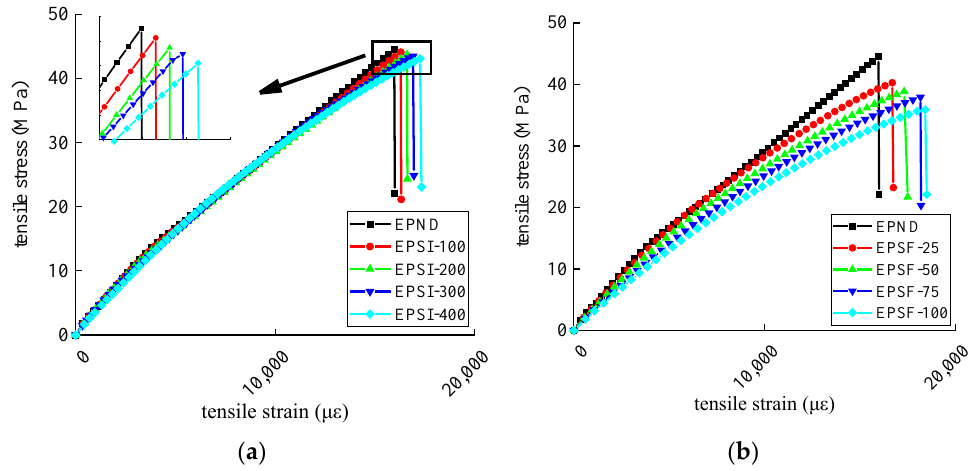
Figure 16. Stress – strain curve of epoxy resin: ( a ) chlorine salt immersion environment and ( b ) salt-freeze coupled environment.